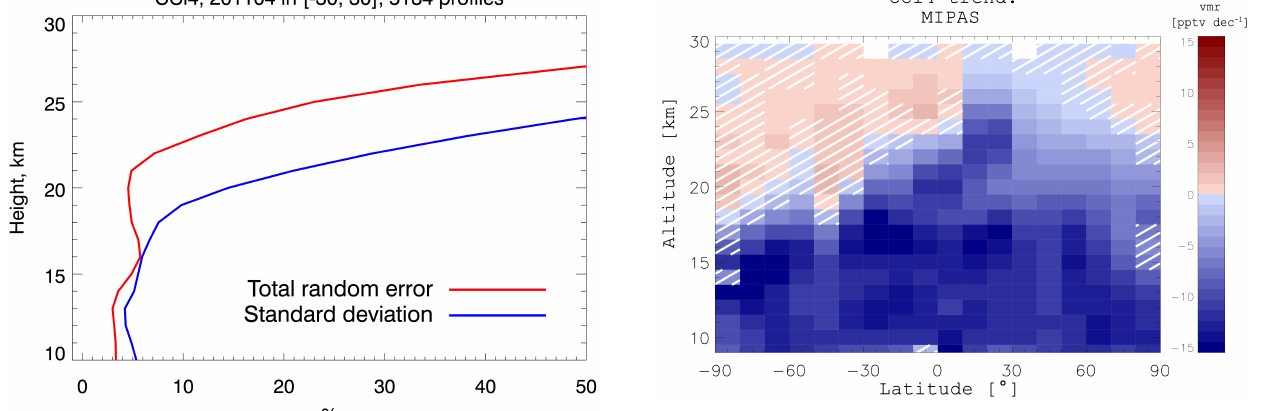
Figure 10. Comparison of the estimated total error with the standard deviation of several MIPAS profiles for a quiescent atmospheric sit- uation (Equator). Red: total error budget; blue: standard deviation.